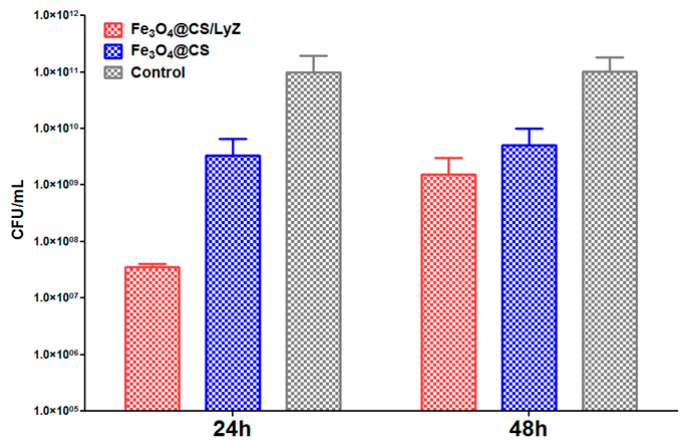
Figure 12. Evaluation of P. aeruginosa microbial biofilm development after 24 and 48 h in the presence of the bioactive nanomodified coatings.